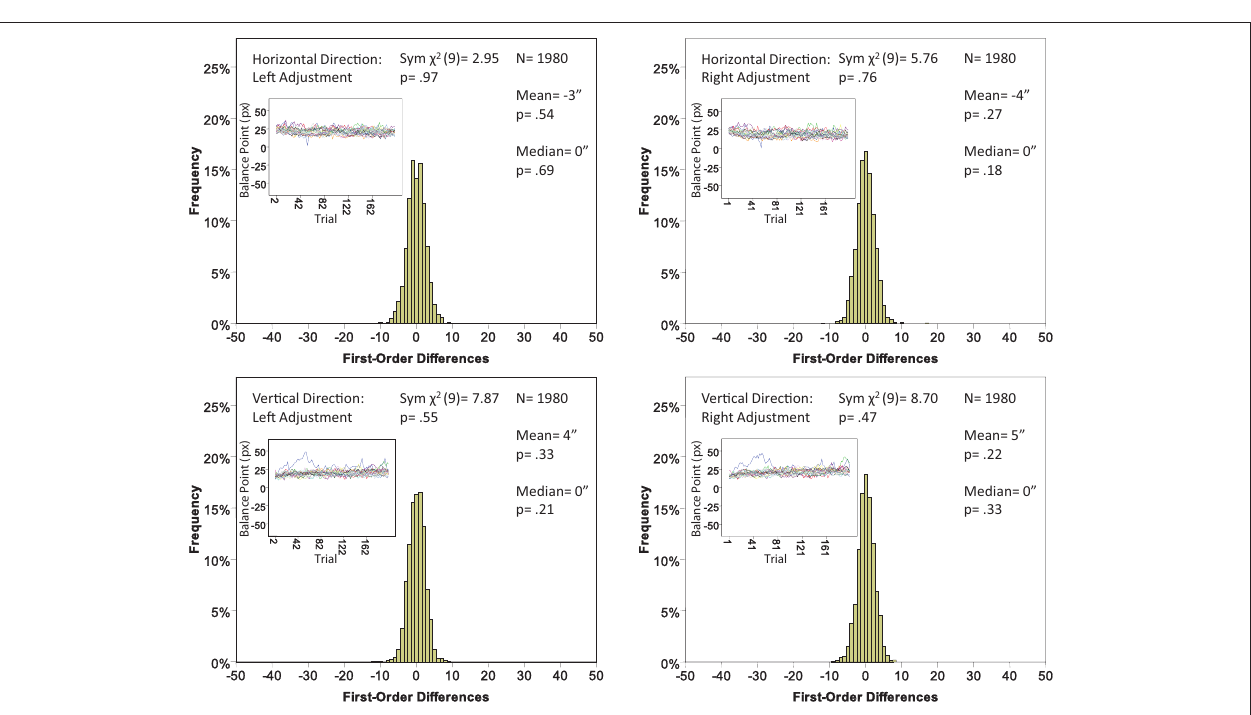
Figure 8 | Histograms of the ∆ ’s for the location experiment, participant P1. The rest as in Figure 7 .